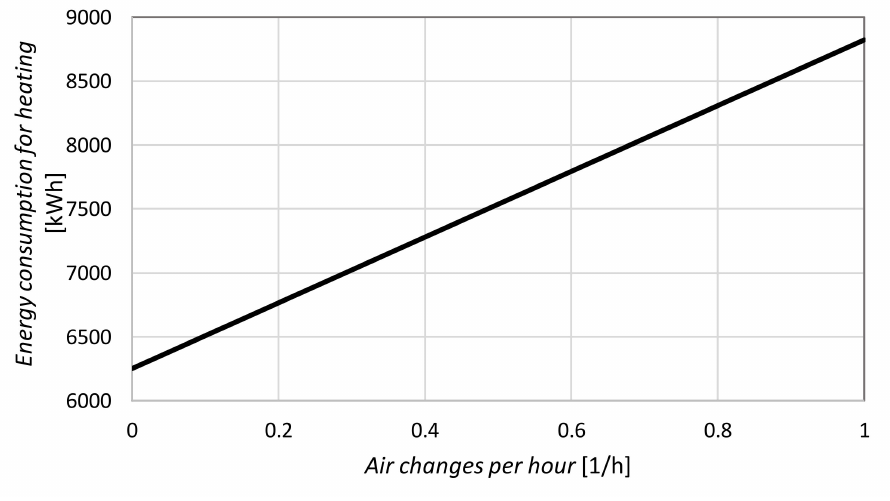
Figure 12. The energy demand for space-heating of the building as a function of the number of air